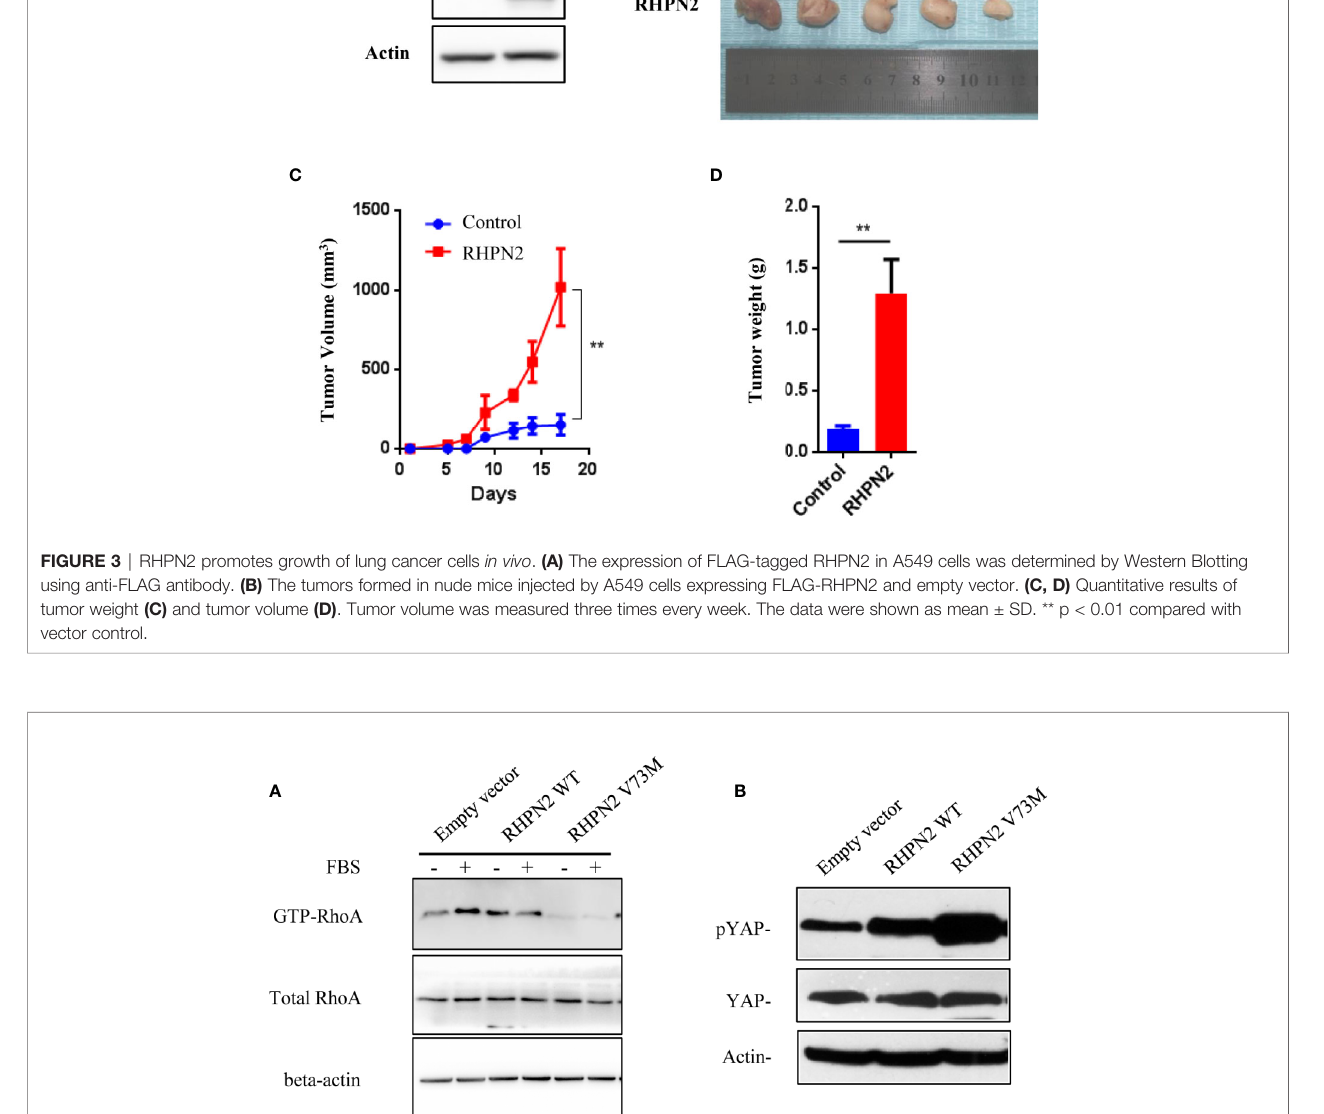
FIGURE 4 | RHPN2 suppresses RhoA signaling. (A) Western blotting showing the expression levels of active RhoA (Rho-GTP) and total RhoA in A549 cells expressing empty vector, WT and mutant RHPN2 with or without serum stimulation. Expression of b -actin serves as loading control. (B) Western blot showing the expression of YAP and p-YAP in A549 cells expressing empty vector, WT and mutant RHPN2. Expression of b -actin serves as loading